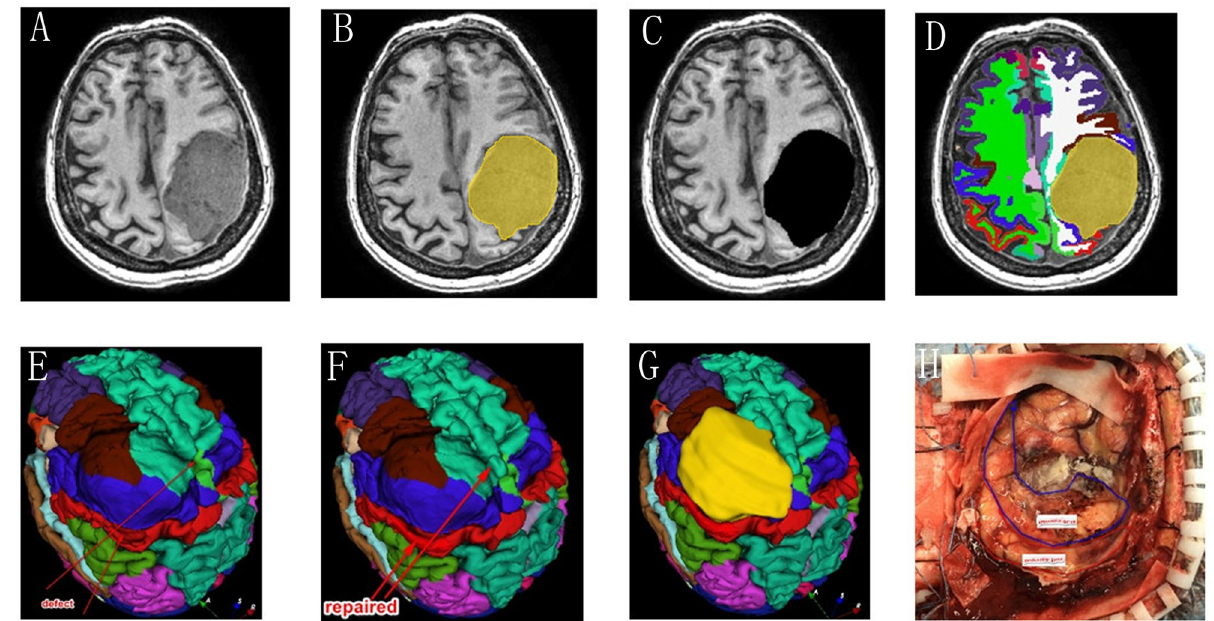
Fig 4. (Sub 15, left convexity meningioma). These images show the segmentation results in an axial slice for manual tumor segmentation in 3D Slicer (A-C) and automatic segmentation for the whole brain in FreeSurfer (D). The model was partially damaged (E), and the defect was repaired with information from the unaffected side of the brain (F). The postcentral, precentral, and superior frontal gyri and the caudal middle frontal cortex were pushed by the tumor (G). According to the above partitions, the “real” lobes can be identified after tumor removal (H).